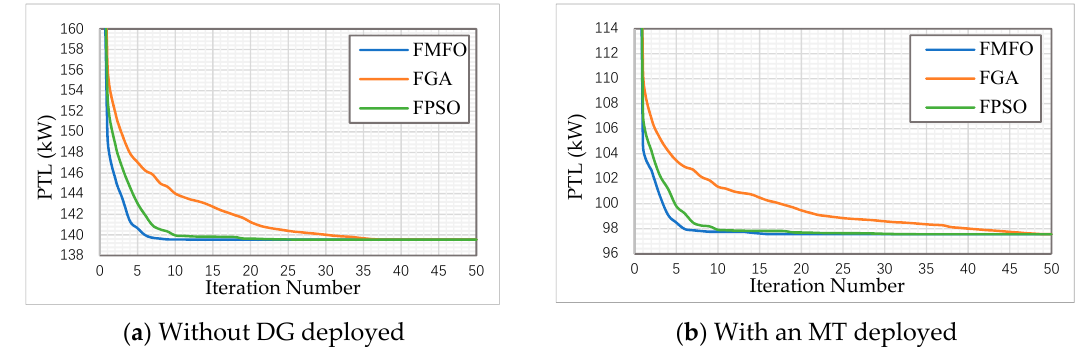
Figure 6. Comparison of convergence of fuzzy genetic algorithm (FGA), fuzzy particle swarm optimization (FPSO), and fuzzy moth-flame optimization (FMFO) on power transmission loss (PTL).